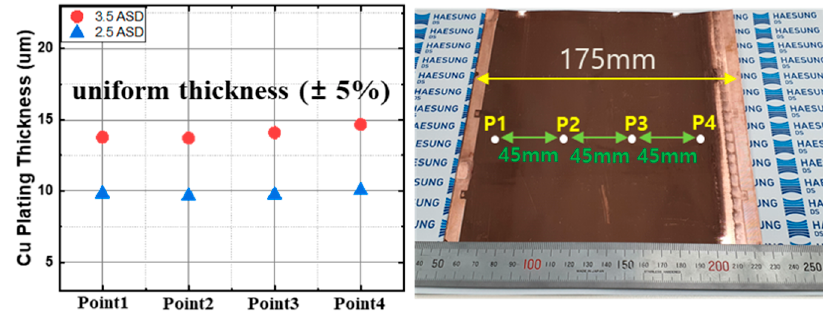
Figure 6. Cu thickness uniformity after Cu plating process.